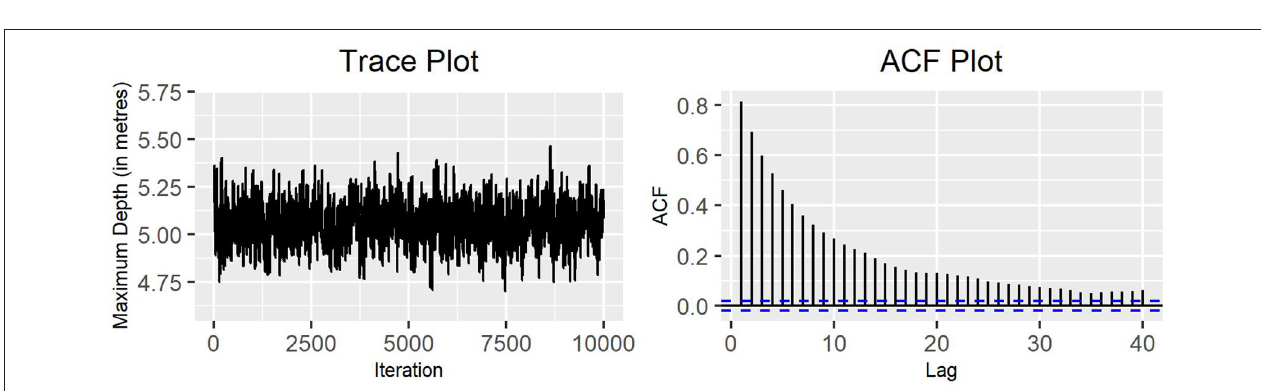
FIGURE 2 | Fitted state-dependent distributions for dive duration , maximum depth , and dive wiggliness .